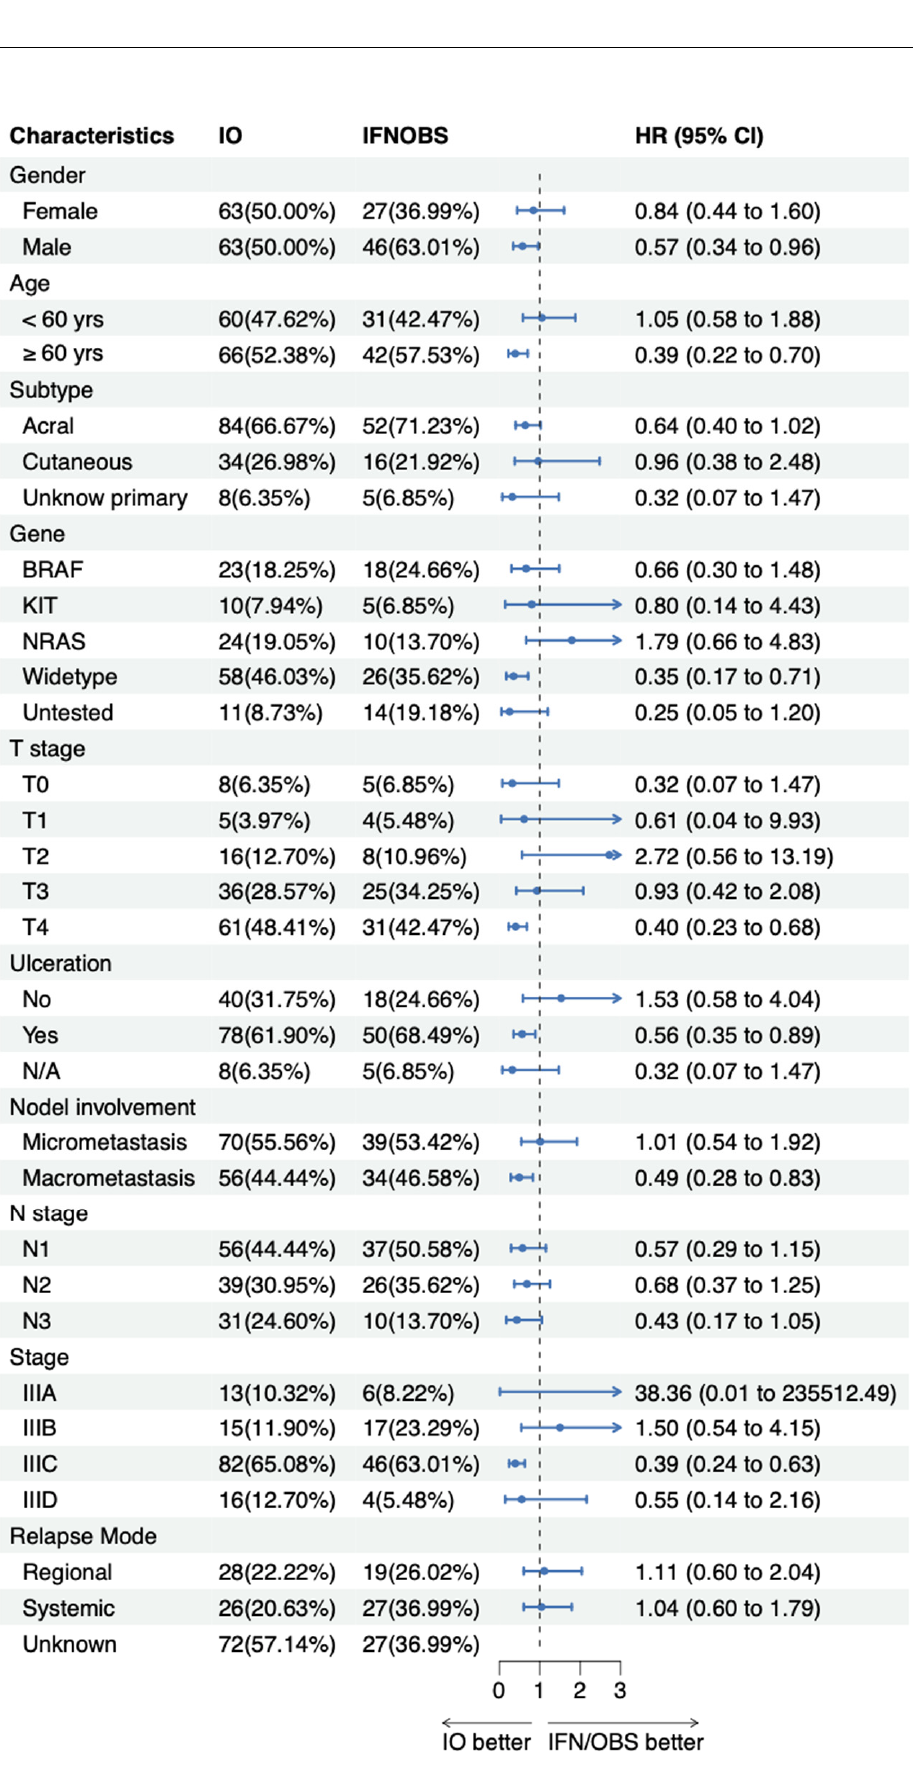
At the time of this report, the median distant metastasis-free survival (DMFS) was not reached in the PD-1 inhibitor group, and it was 72 months in the IFN group and 20 months in the observation group (Table S2). The 1-year DMFS rates for the PD-1 group, IFN group, and OBS group were 84.7%, 85.3%, and 58.6%, while the 2-year DMFS rates were 69.4%, 68.5%, and 48.4%, respectively. The treatment of PD-1 inhibitor caused sig- nificantly longer DMFS than simple observation (NR vs. 20 months, p = 0.014). No notable